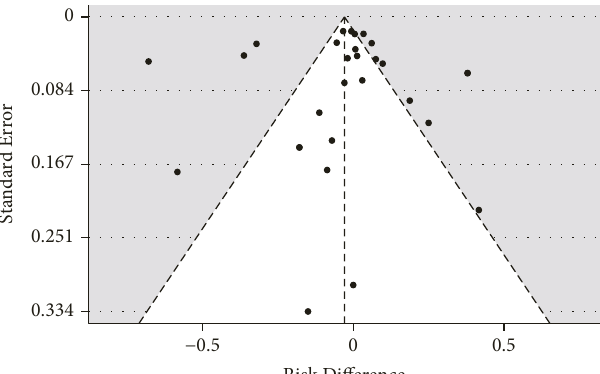
Figure 4: Funnel plot of individual risk differences against their standard errors. Egger’s regression for funnel plot asymmetry ( p � 0 .